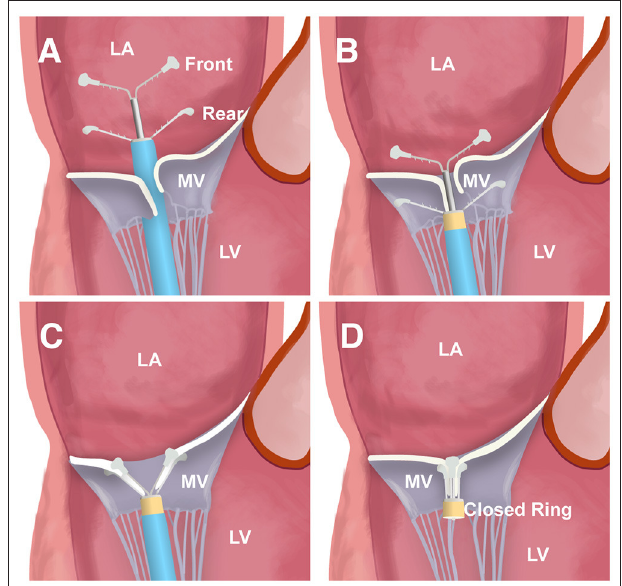
FIGURE 1 | The main steps of ValveClamp implantation. (A) The clamp is delivered and opened within the left atrium (LA). (B) The clamp is adjusted to the appropriate position; the rear clamp is placed just under the leaflets, and the front clamp remains within the LA. (C) The front clamp is pulled back to capture the leaflets, and then the closed ring is moved forward to cover the ventricular end of the clamp arms, approximating the mitral valve (MV) leaflets and strengthening the clamp. (D) The clamp is